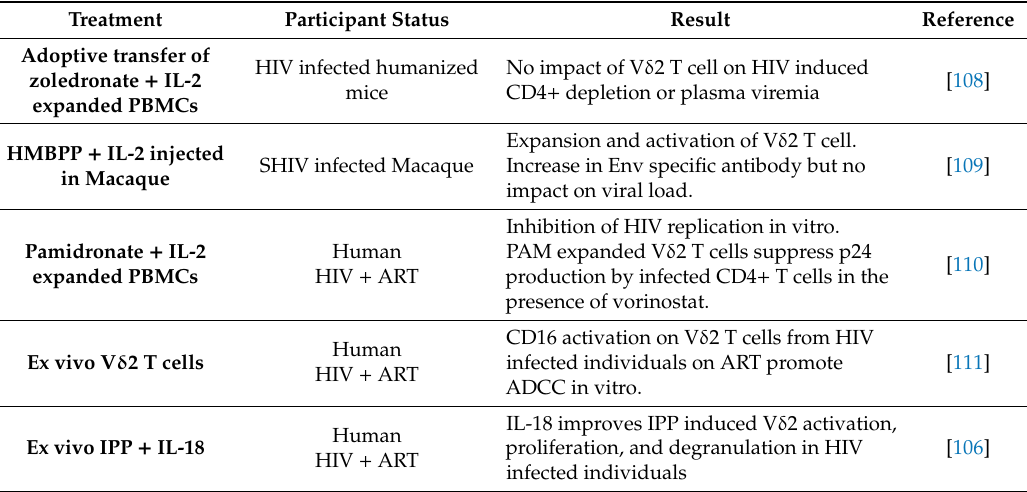
Table 2. HIV immunotherapy studies using V δ 2 T